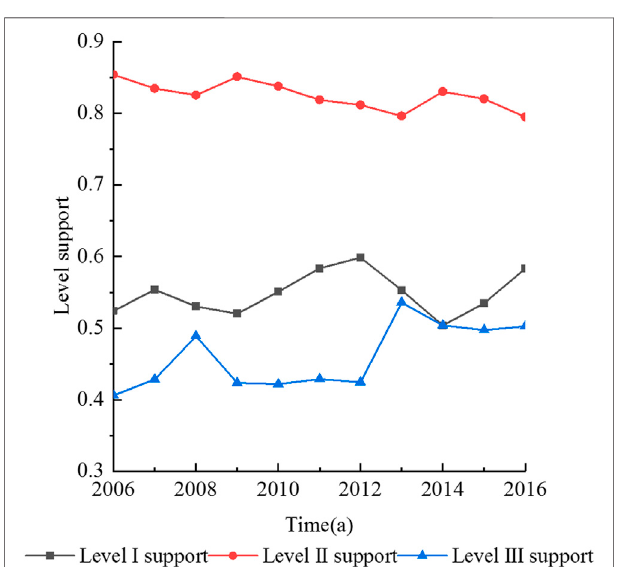
FIGURE 12 | Evolution curve of the support degree under natural